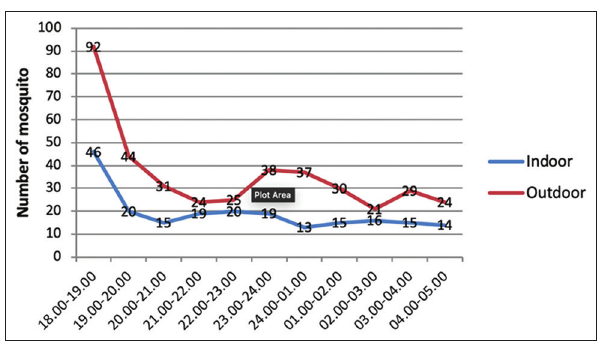
Figure-1: Periodicity of Armigeres subalbatus from Lubuk Pauh